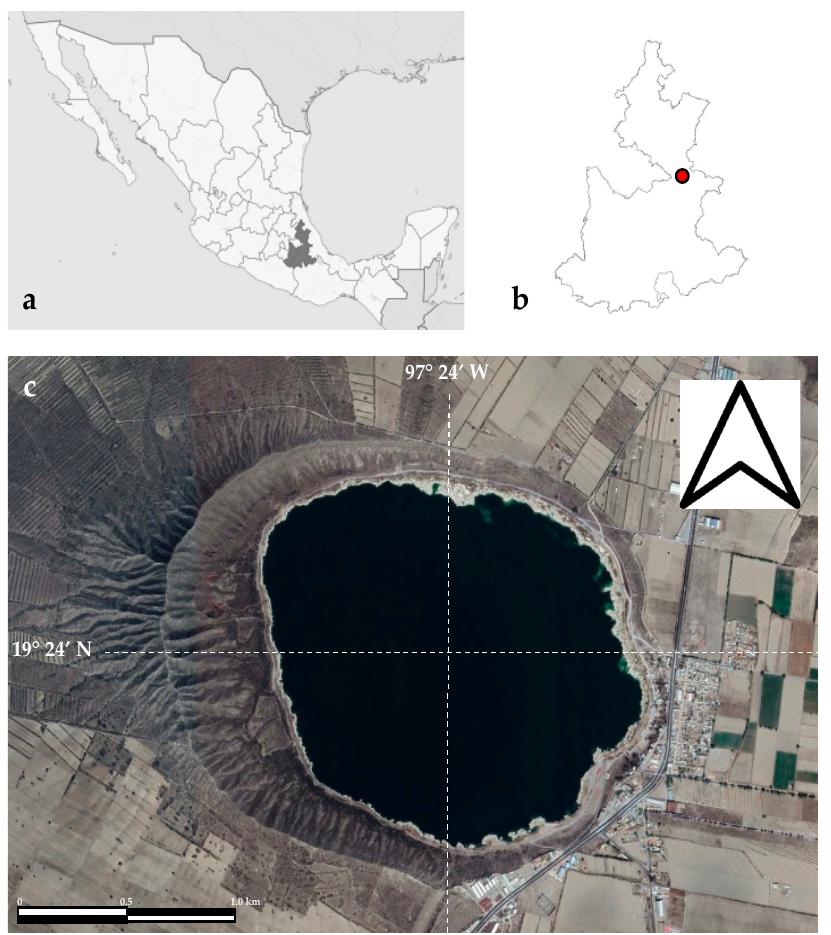
Figure 1. Location of Lake Alchichica in ( a ) Mexico and ( b ) Puebla State. ( c ) Lake Alchichica (satellite photograph from Google Earth).